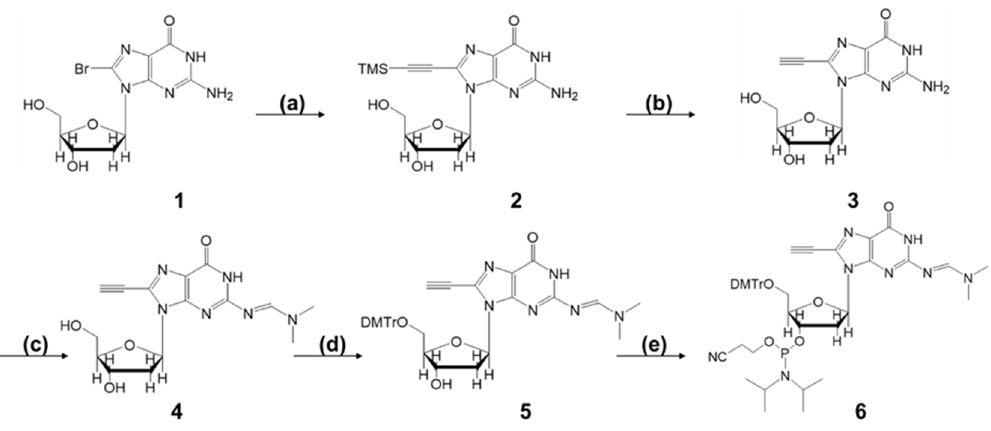
Scheme 1. Reagents and conditions: ( a ) Trimethylsilyl acetylene, Tetrakis(triphenylphosphine)palladium,